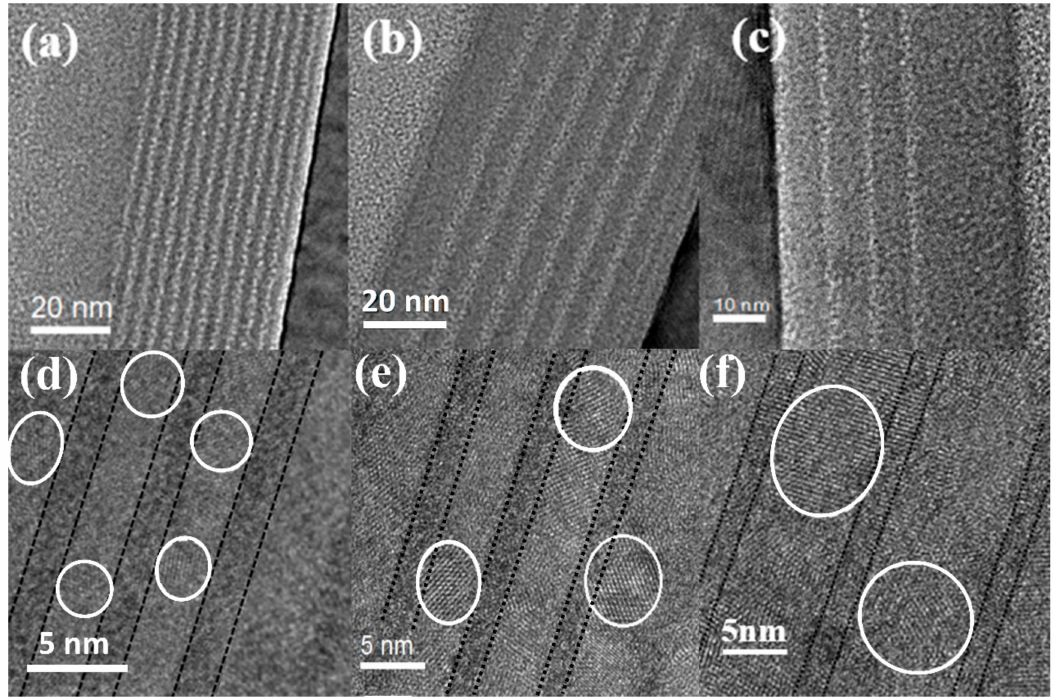
Figure 1. Cross-section TEM images of ( a ) a-Si (2 nm) / a-SiC (2 nm) multilayers (MLs); ( b ) a-Si (4 nm) / a-SiC (2 nm) MLs; ( c ) a-Si (8 nm) / a-SiC (2 nm) MLs; ( d ) Si quantum dots (QDs) (2 nm) / SiC (2 nm) MLs; ( e ) Si QDs (4 nm) / SiC (2 nm) MLs; ( f ) Si QDs (8 nm) / SiC (2 nm) MLs.